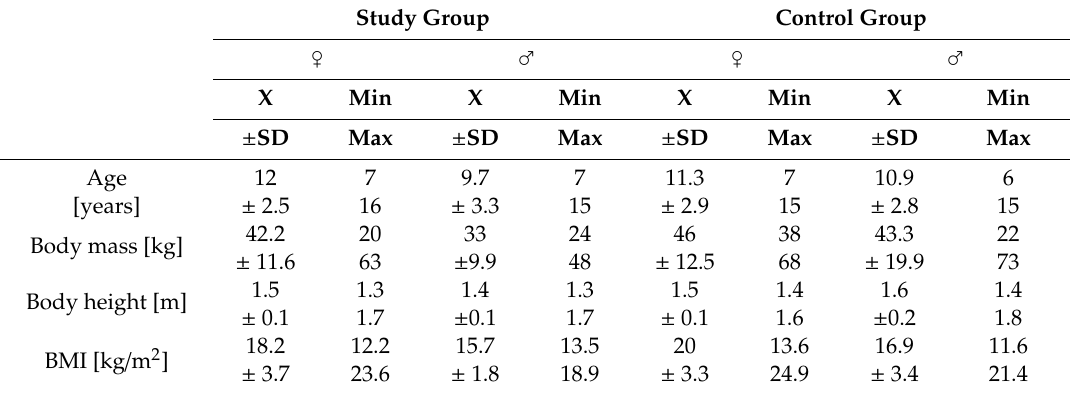
Table 1. Anthropometric characteristics of the subjects from particular groups. Study